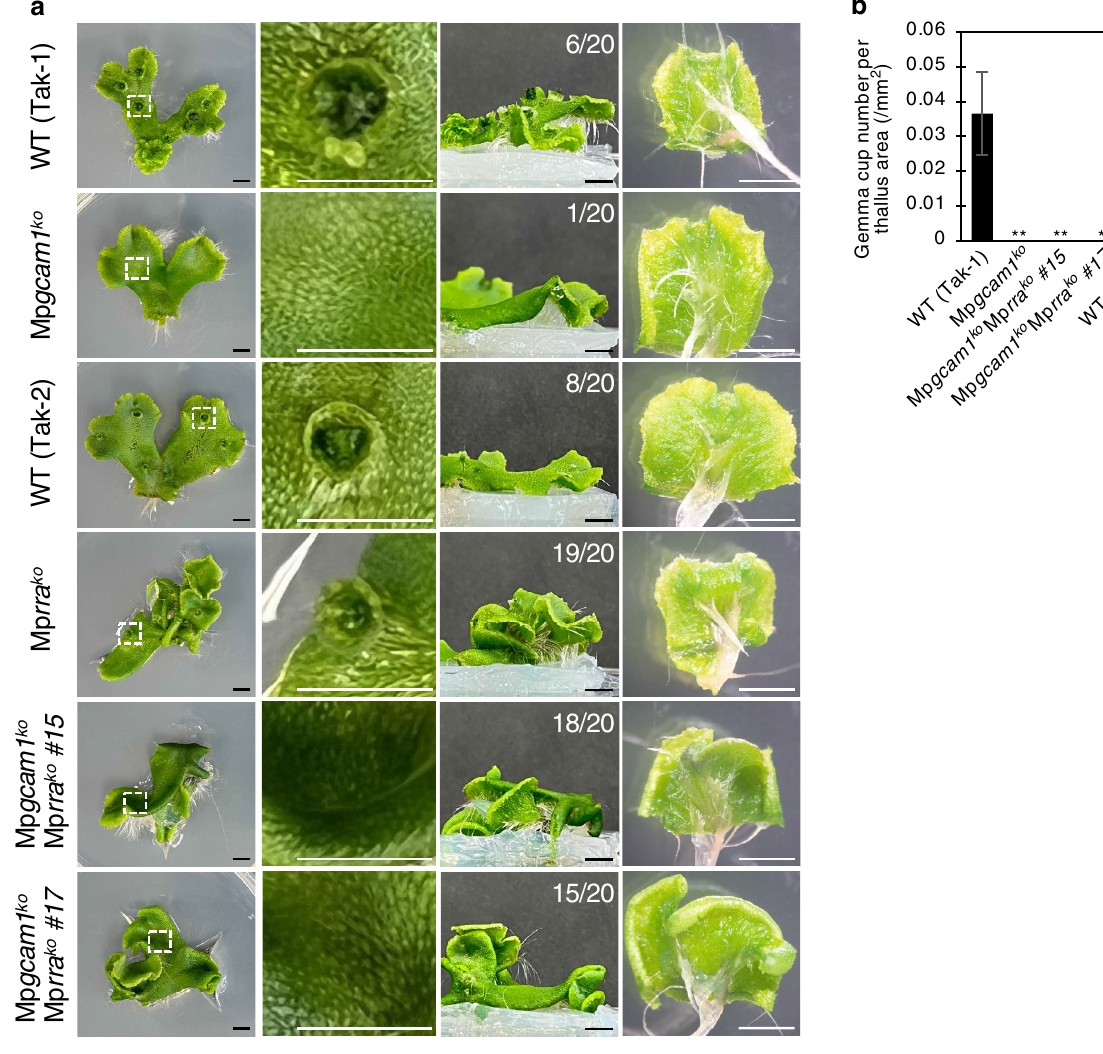
Figure 4. Morphological phenotype of the Mp gcam1 Mp rra double mutant. ( a ) Thalli of the Mp gcam1 and Mp rra single mutants, and the Mp gcam1 Mp rra double mutant were observed from the top (left), from the side (second from the right), and from the bottom (right). Magnified images of gemma cups or predicted position for gemma cup formation are shown (second from the left). The numbers in the side views indicate the number of curled thalli per total thalli. Bars represent 5 mm. ( b ) Gemma cup number per thallus area. Thallus apices were cultured for 14 days. Data are represented as mean ± SD ( n = 20). Significant differences from the wild-type (Tak-1 and Tak-2) were determined by the Student’s t-test as follows: ** P <